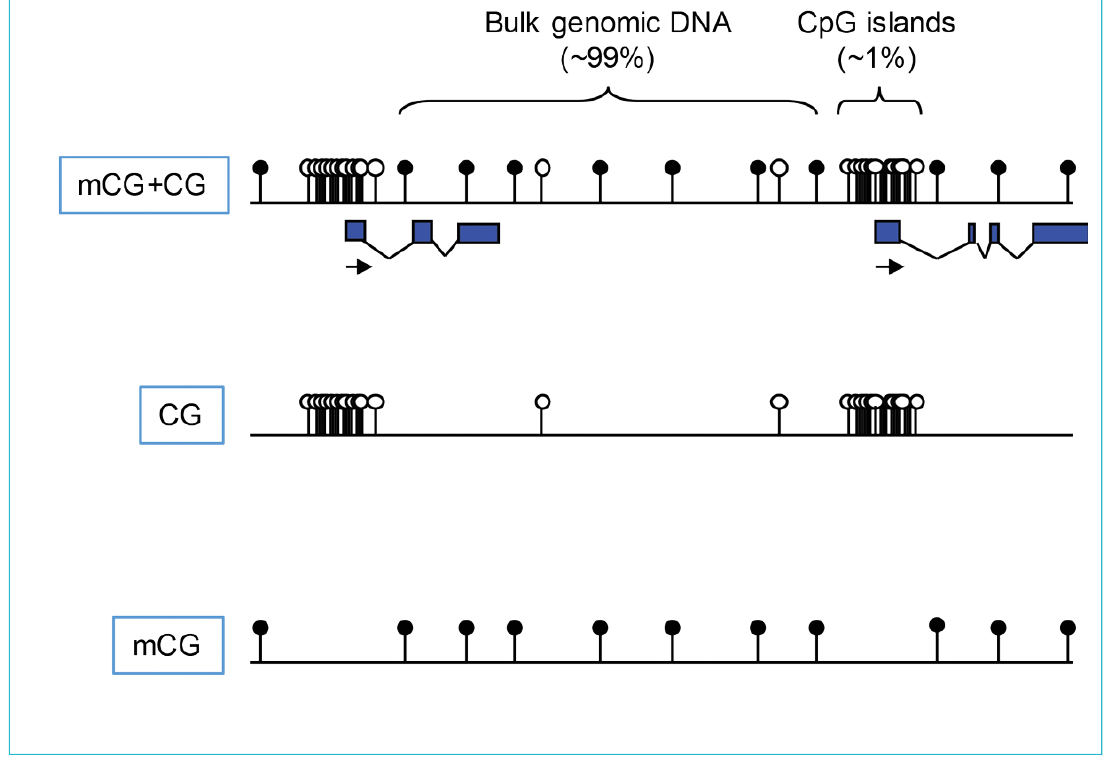
Figure 2: CpG and methyl-CpG have very different distributions across the genome. The dinucleotide CpG occurs in two chemical forms that attract or repel different protein complexes (e.g., via CpG- or mCpG-binding